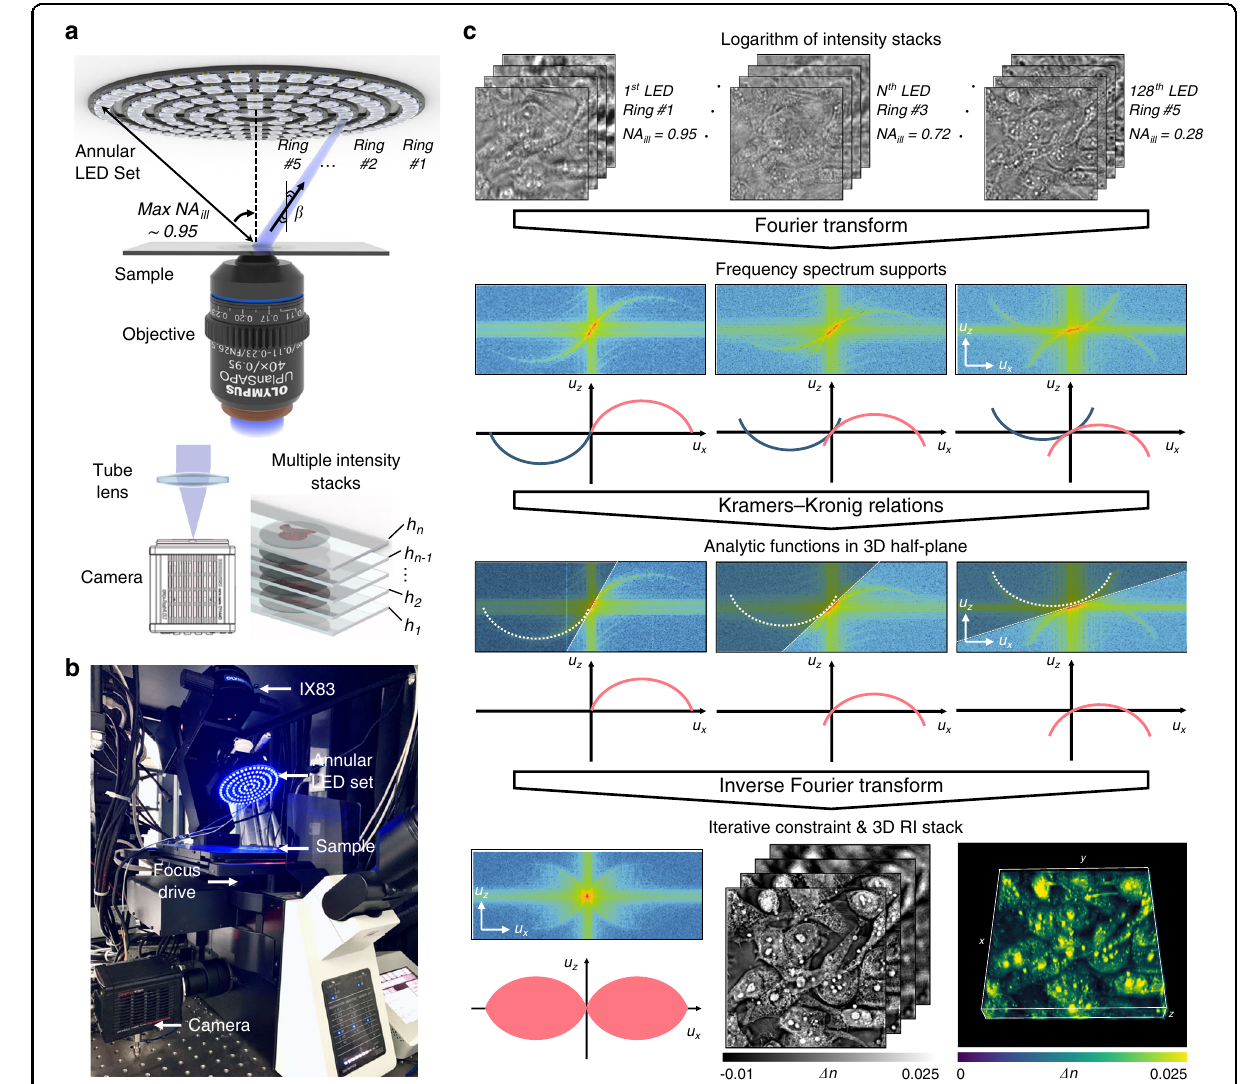
Fig. 2 Hardware implementation and working fl ow of TIDT-NSA. a Setup of TIDT-NSA system based on a commercial microscope equipped with a multi-annular programmable LED source at the front-end of illumination and a scanning drive mechanism at the back-end of acquisition. b A photo of our TIDT-NSA hardware system. c Flowchart of data processing in TIDT-NSA for 3D RI reconstruction on the example of unstained MCF-7